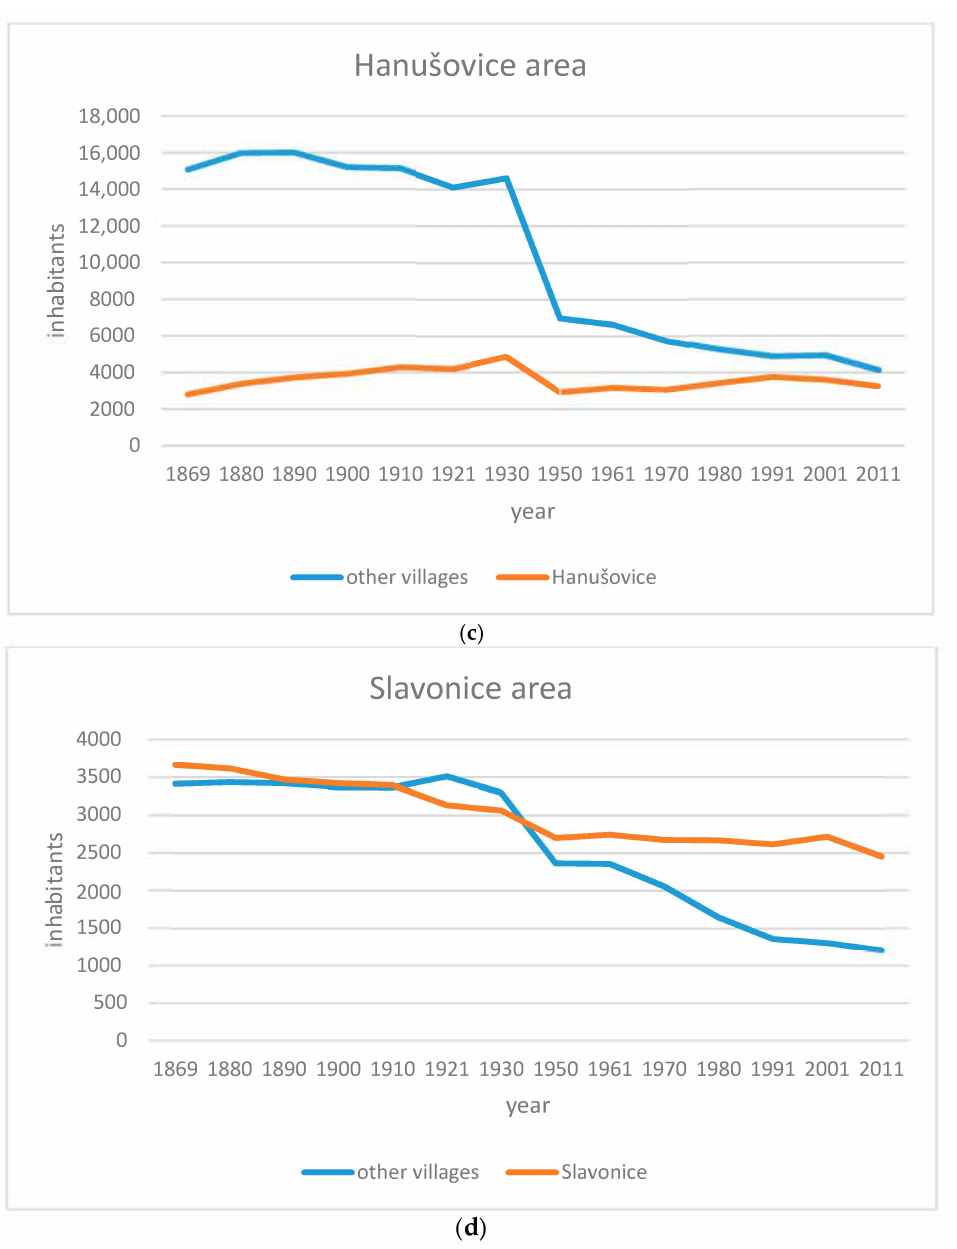
Figure 6. ( a ) Population development in the Javorn í k area 1869–2011, ( b ) population development in the Osoblaha area 1869–2011, ( c ) population development in the Hanušovice area 1869–2011 and ( d ) population development in the Slavonice area 1869–2011; Data source: Historick ý lexikon obc